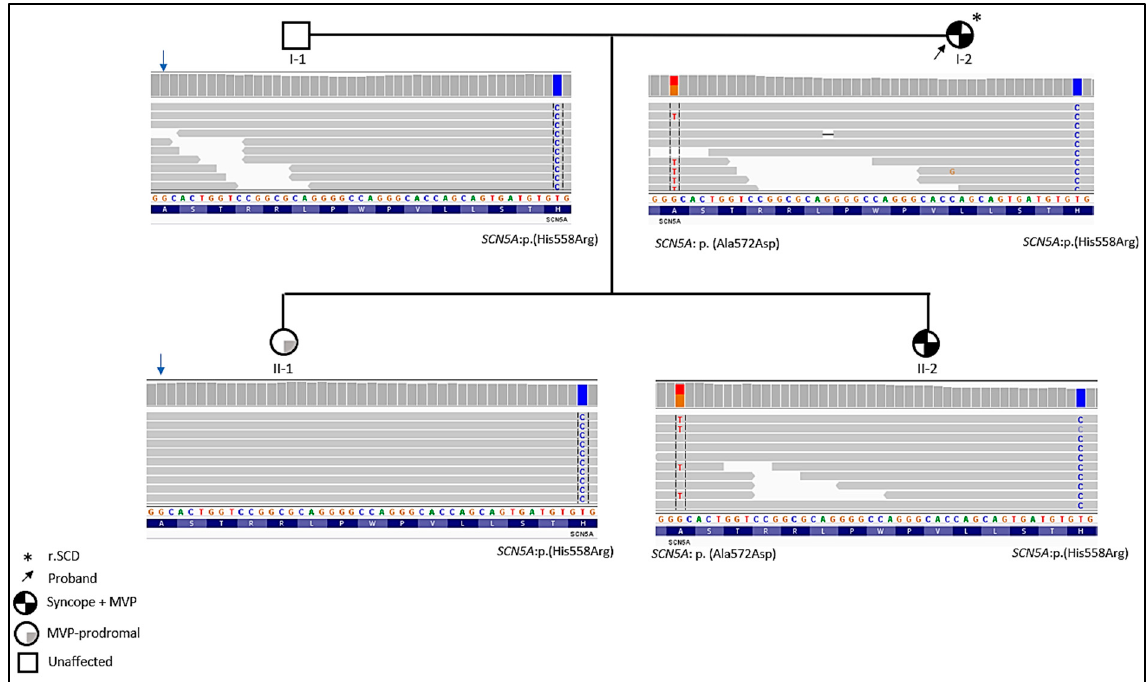
Figure 3. Family pedigree and integrative genomics viewer visualization showing the p.(Ala572Asp) and p.(His558Arg) in the SCN5A gene. Both symptomatic family members (I-2 and II-2) carried the two variants. The father and the paucisymptomatic daughter (II-1) carried only the p.(His558Arg) polymorphism (Figure 3).